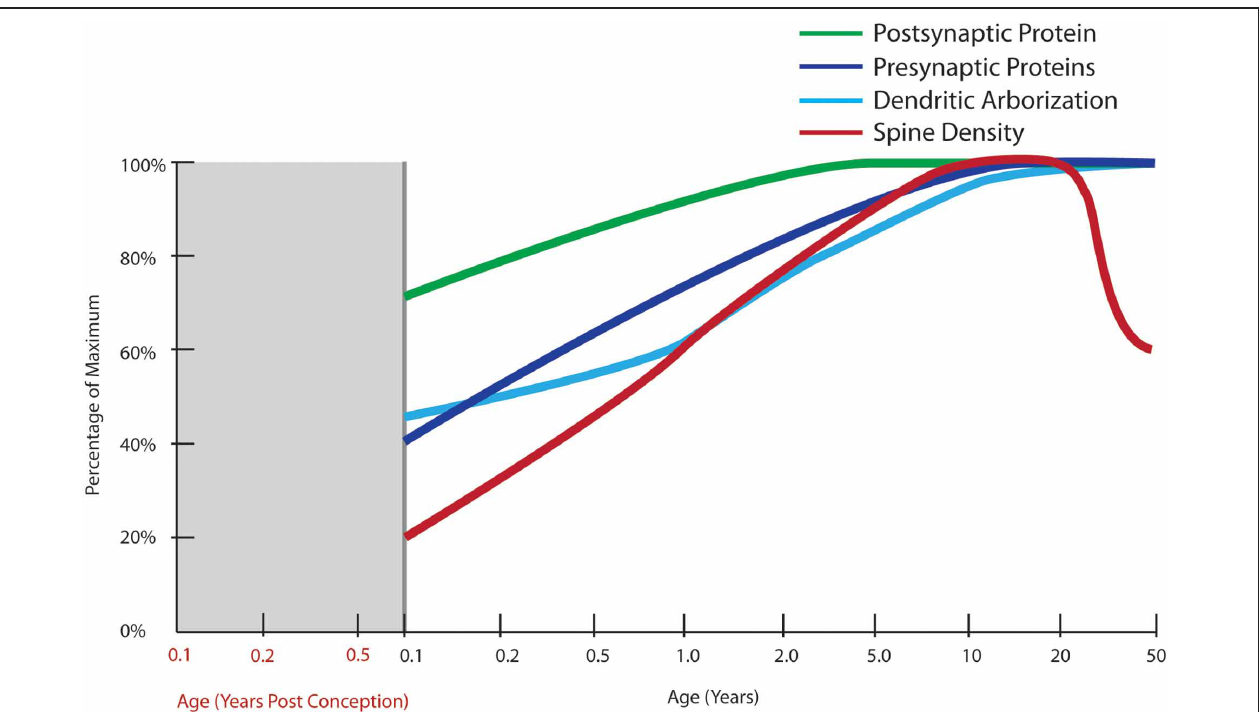
2011). Dendritic arborization indexed by average length of the total dendritic tree of layer III pyramidal neurons does not reach its maximum until adulthood with a slight decline after the age of 30 years (Petanjek et al., 2008). Quantification of Golgi-impregnated tissue suggests an increase in spine density from birth until early school age, followed by a period of gradually decreasing density starting in early adulthood which lasts until middle age (Petanjek et al.,